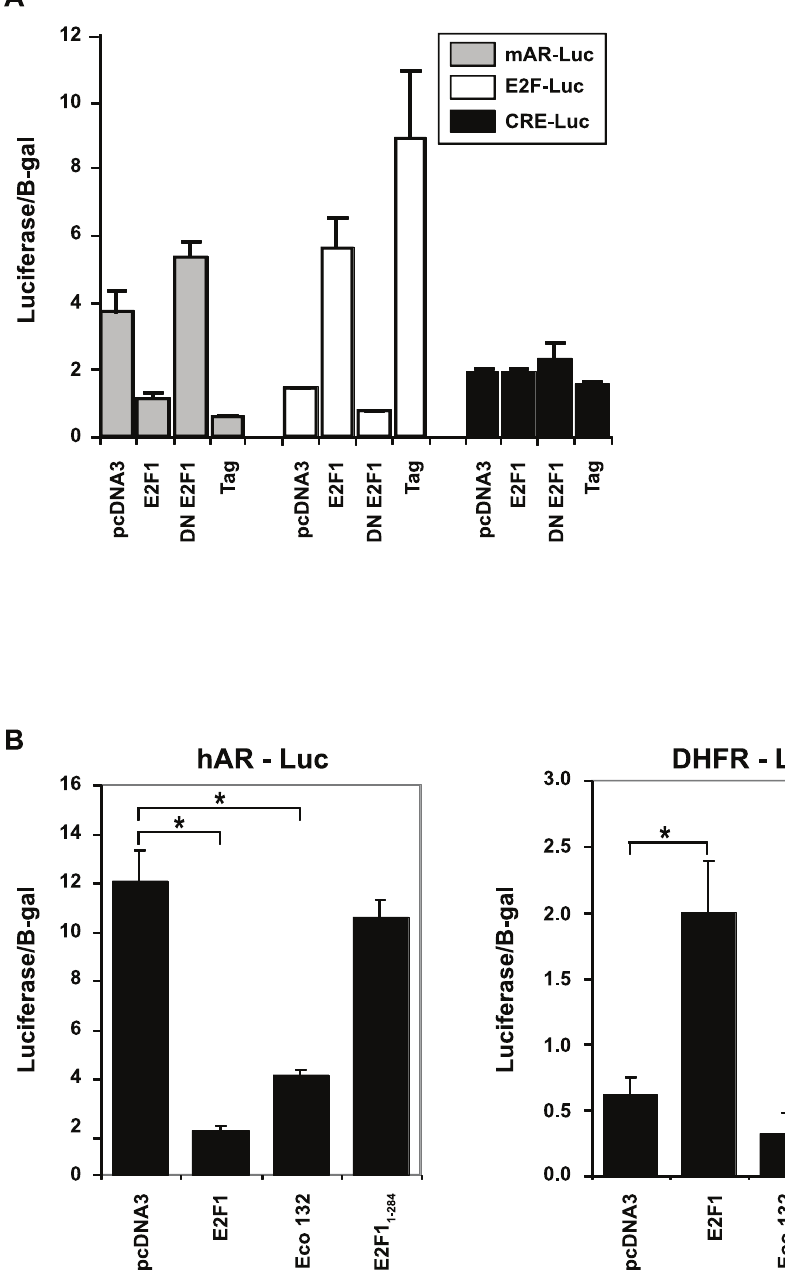
Figure 3. The E2F1 transactivation domain is required for AR promoter activity repression. ( A) mPrE cells were co-transfected with 1 m g of mARp-Luc, E2F-Luc or CRE-Luc luciferase reporter constructs with 0.5 m g of empty vector (pcDNA3), wild type E2F1, dominant negative E2F1 (DN E2F1) or SV-40 Large T antigen (Tag). After 72 hours, cells were harvested and assayed for luciferase expression. The results are shown as averages of three independent experiments. Assays were done in triplicate and mean values are shown with standard deviation. The results were normalized to b -galactosidase (B-gal) expression from a co-transfected CMV promoter driven B-gal reporter construct. (B) LNCaP cells were co-transfected with either 1 m g of hAR-Luc or DHFR-Luc and 0.5 m g of either wild type E2F1or E2F1 1–284 mutant constructs. The histograms represent the mean value of three independent experiments with the indicated standard deviation. Results were normalized to b -galactosidase (B-gal) expression from a co- transfected CMV promoter driven by a B-gal reporter construct. * indicates P , 0.05 for the indicated comparison in brackets.